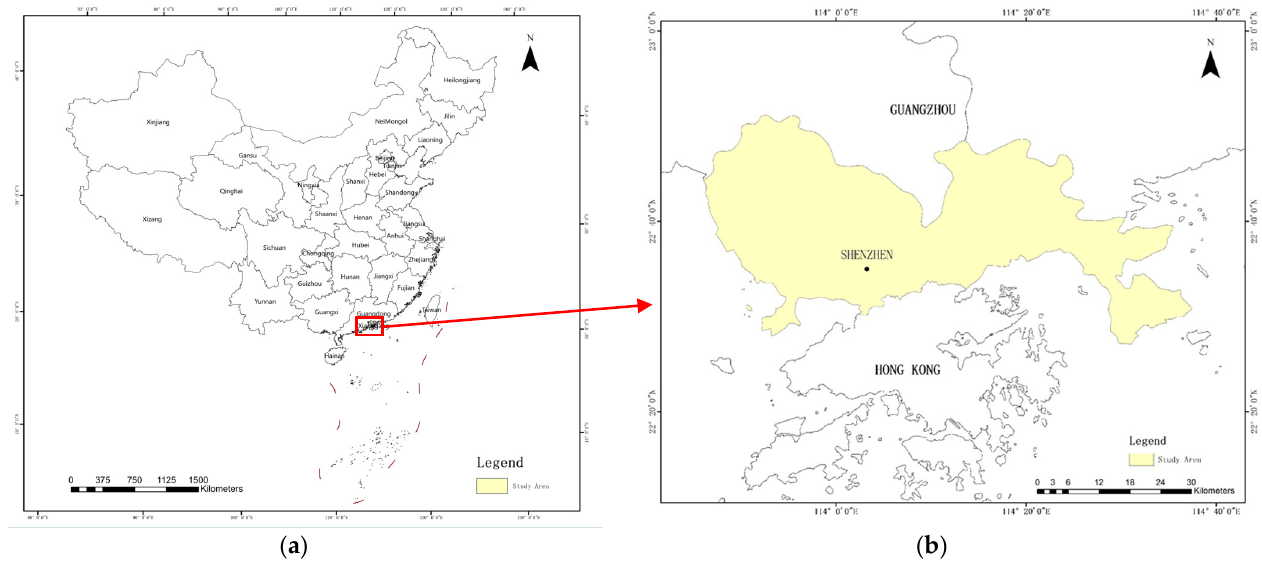
Figure 1. Schematic diagram of the geographical location of the study area. ( a ) Shenzhen’s location in China. ( b ) Overview of Shenzhen. Table 1. Detailed information of the study data.